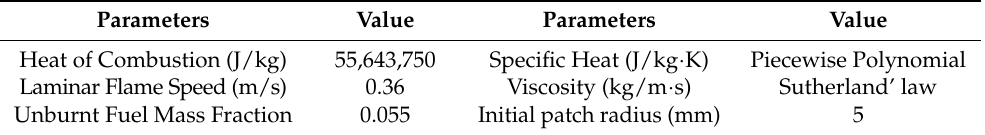
Table 3. Detailed computational